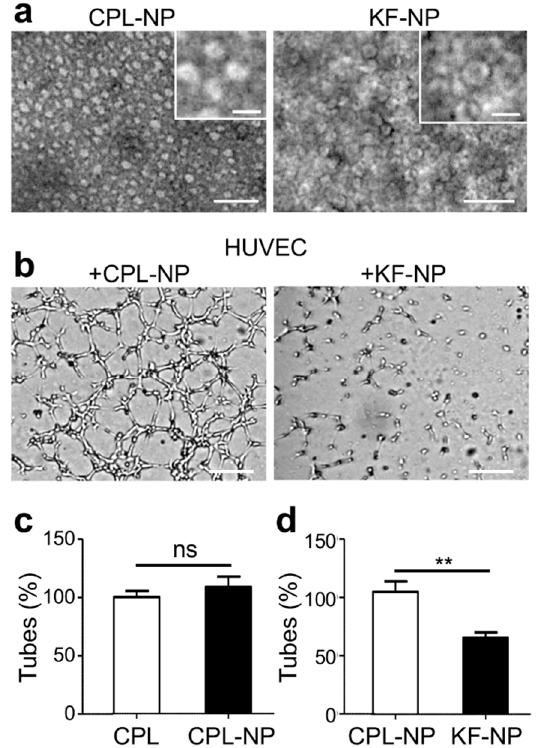
Figure 7. Characterization of monotype and mixed CPL nanoparticles by transmission electron microscopy (TEM) and effect on angiogenesis. ( a ) TEM images of nanoparticle assemblies (disks) derived from CPL and from a mixture of CPL, CPL-K, and CPL-F (KF). Scale bar, 100 nm; scale bar in insert figures, 25 nm; ( c , d ) Phenotype ( b ) and quantification ( c , d ) of the tubule formation by HUVECs in matrigel. The number of tubes per field was measured four hours after cell plating and upon addition of the di ff erent CPL assembly formulations. N = 3 experiments, five wells quantified per condition for each experiment. Scale bar, 200 µ m. Note that CPL and CPL-NP do not inhibit tube formation. In contrast, particles made of the mixture of CPL, CPL-K and CPL-F (KF-NP) significantly reduce tube formation. N = 3 experiments. ns > 0.01; ** p < 0.001 (Mann–Whitney